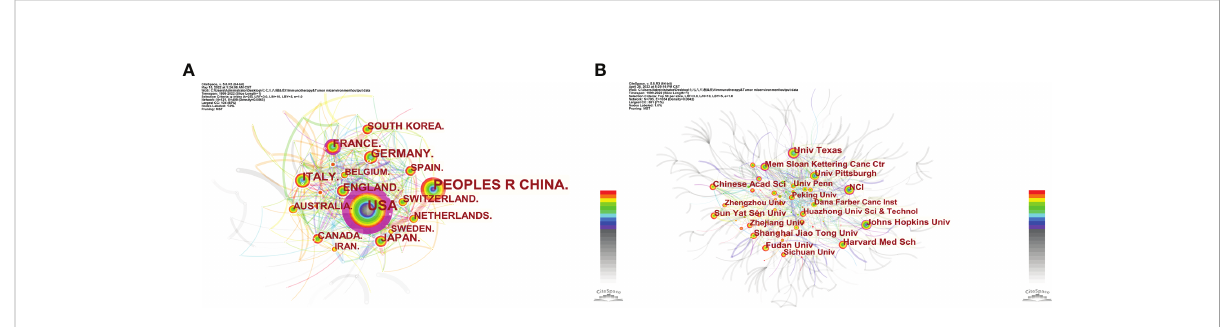
FIGURE 4 Co-occurrence map of (A) nations/regions and (B) organizations in immunotherapy-TME studies. 4The size of nodal points denotes co- occurrence frequency, and the links co-occurrence associations. The colors of node points and lines denote years, where colors vary from purple to red for years between 1999 and 2022. Round purple nodal points denote high betweenness centrality ( ≥ 0.10).